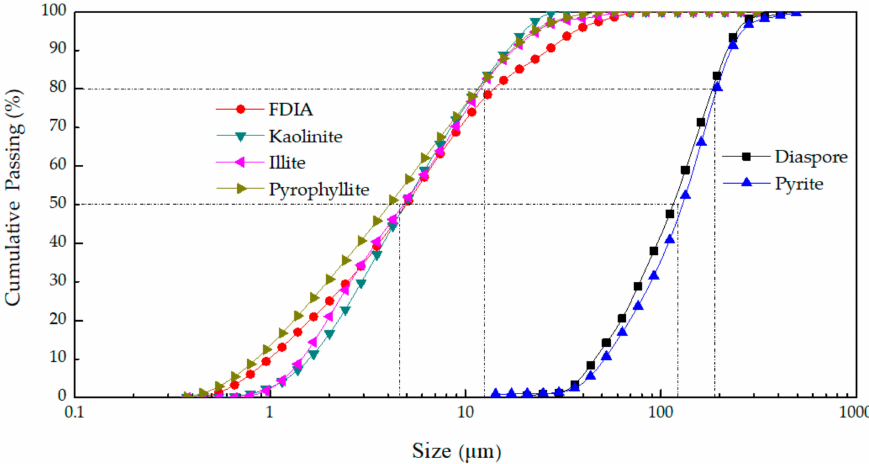
Figure 3. Particle size distribution of the four fine minerals, diaspore, and